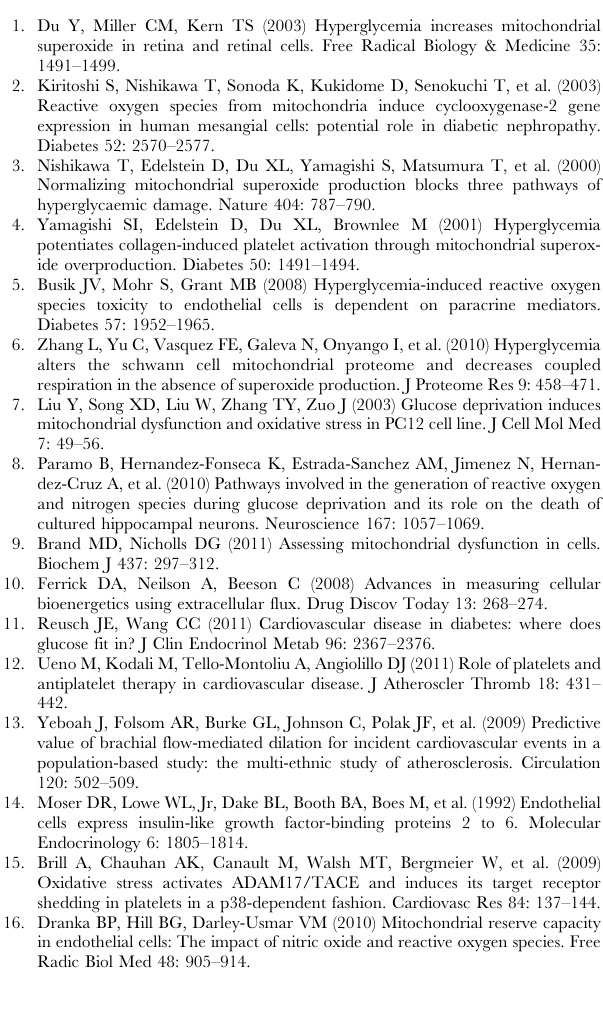
Figure S7 Platelets adhere to respirometer plates. Platelets were imaged by light microscopy after Seahorse runs (as performed in figure 6, main manuscript). A) Platelets exposed to 5.5 mM glucose B) Platelets exposed to 25 mM glucose. Magnification x 40. Each panel is representative of 3 repetitions.